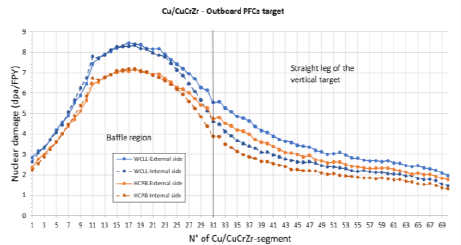
Figure 41. Outer poloidal profiles of the nuclear damage (dpa/FPY) on Cu/CuCrZr components, comparing the values on the external and innermost target sides, both for WCLL and HCPB blanket case.